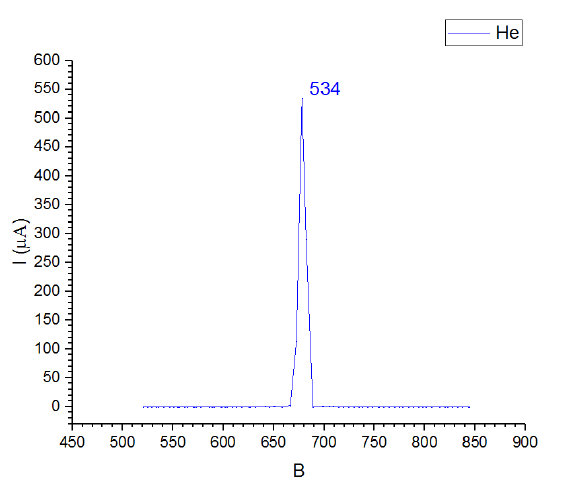
Fig. 7. Spectrum of helium ions with the diameter of extraction hole 3